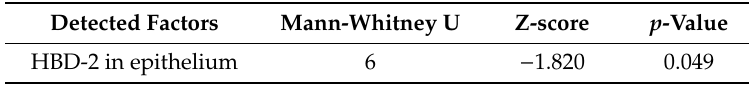
Table 2. Mann–Whitney U test revealing statistically significant difference between rosacea-affected subjects and the control group. Abbreviations: HBD-2, human beta defensin